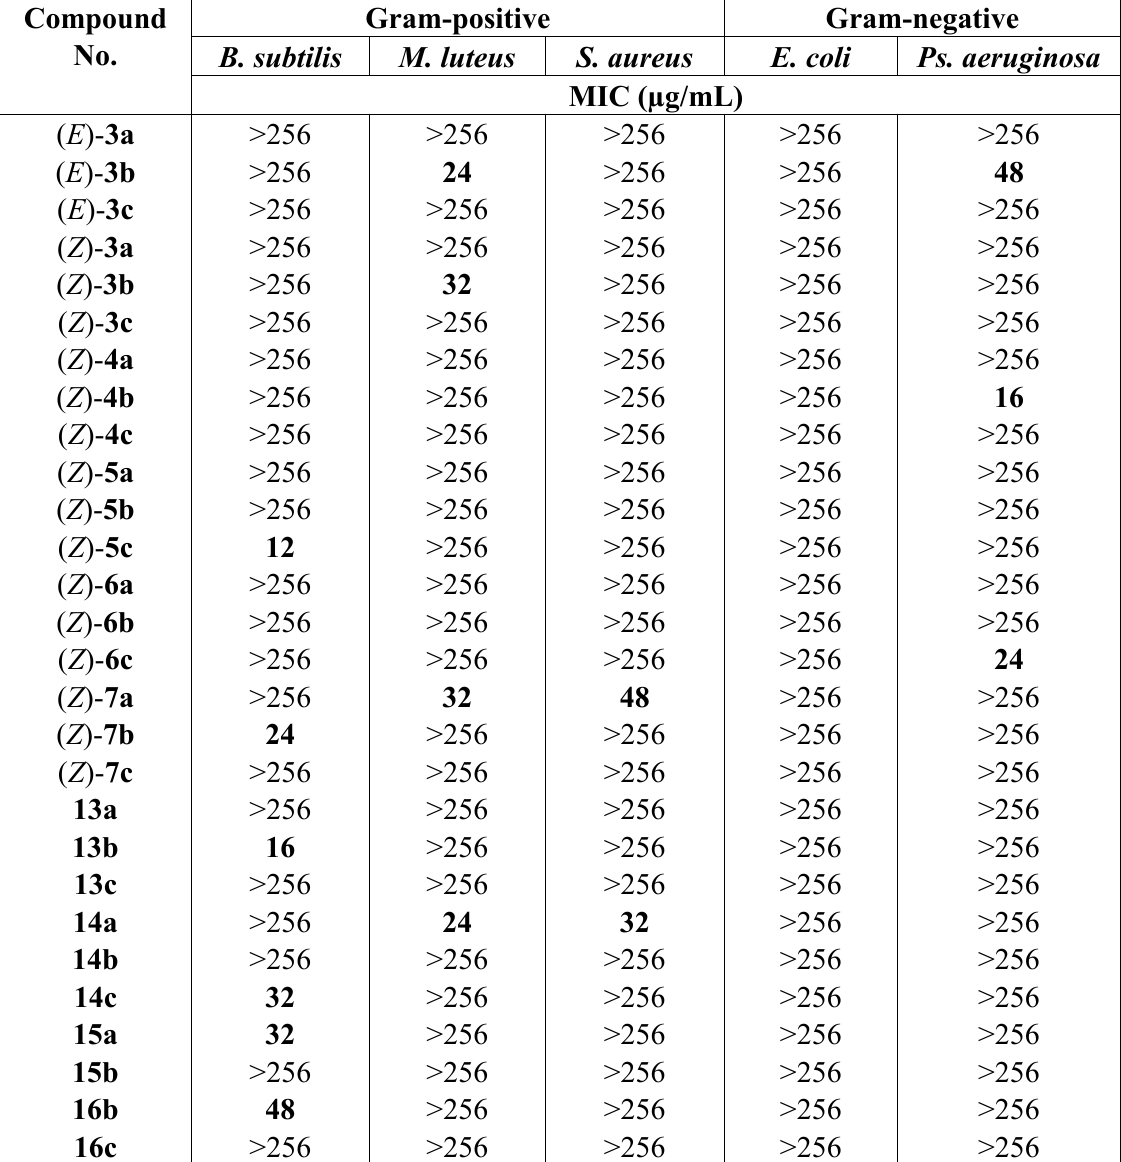
Table 1. Minimum inhibitory concentration (MIC) (µg/mL) of compounds 3–7 and 13–16 against selected bacterial